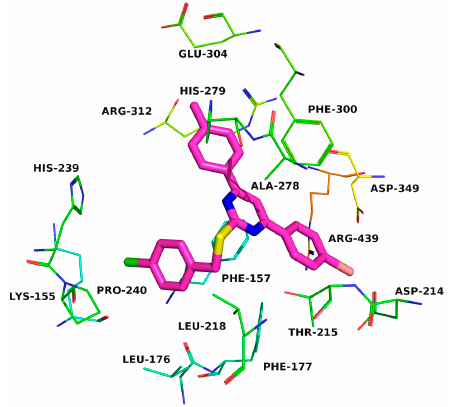
Figure 2. Compound 6j was docked to the binding pocket of the Saccharomyces cerevisiae α -glucosidase.